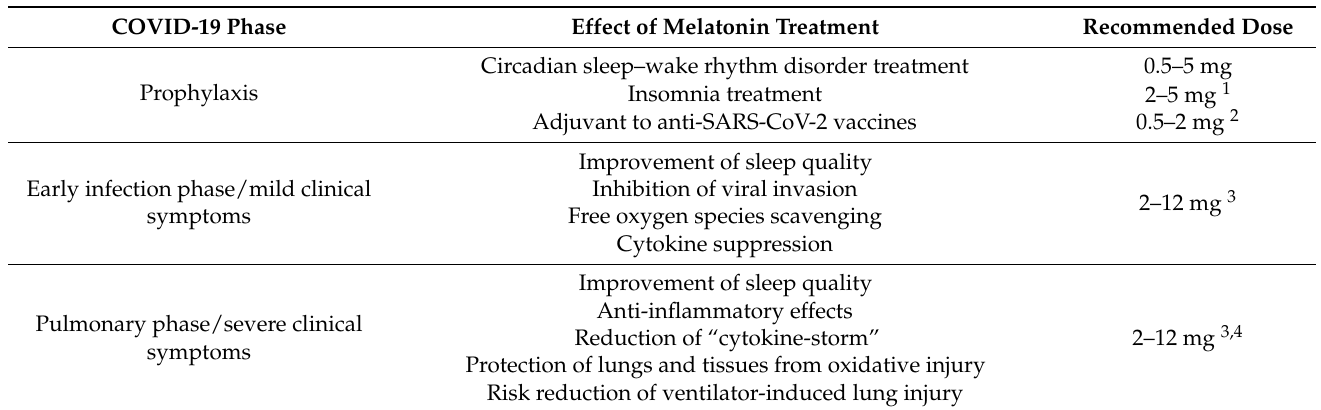
Table 1. Potential effects of melatonin on the course of COVID-19 (modified from: [27,29–31]). COVID-19 Phase Effect of Melatonin